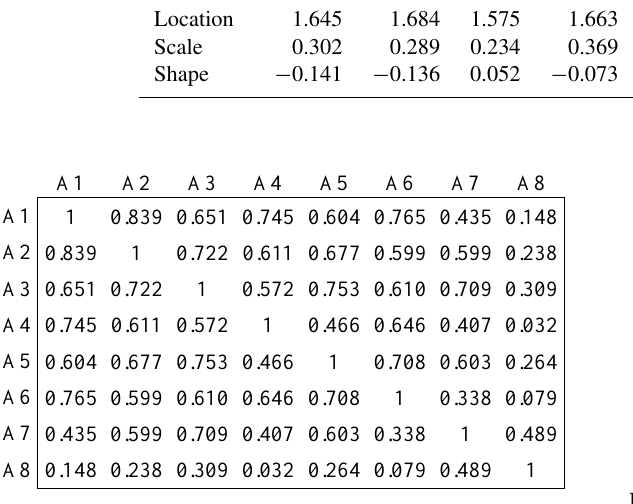
Figure 5. Matrix of correlative coefficients of precipitation between two sub-regions.